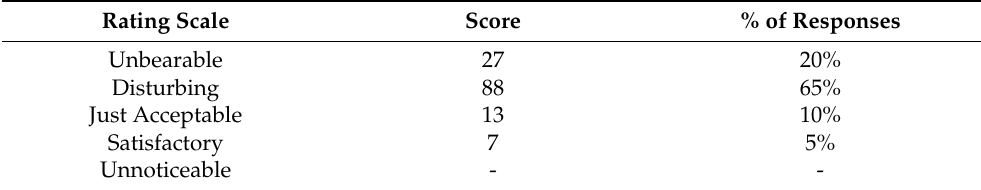
Table 5. Responses to the measurement of discomfort glare (n =